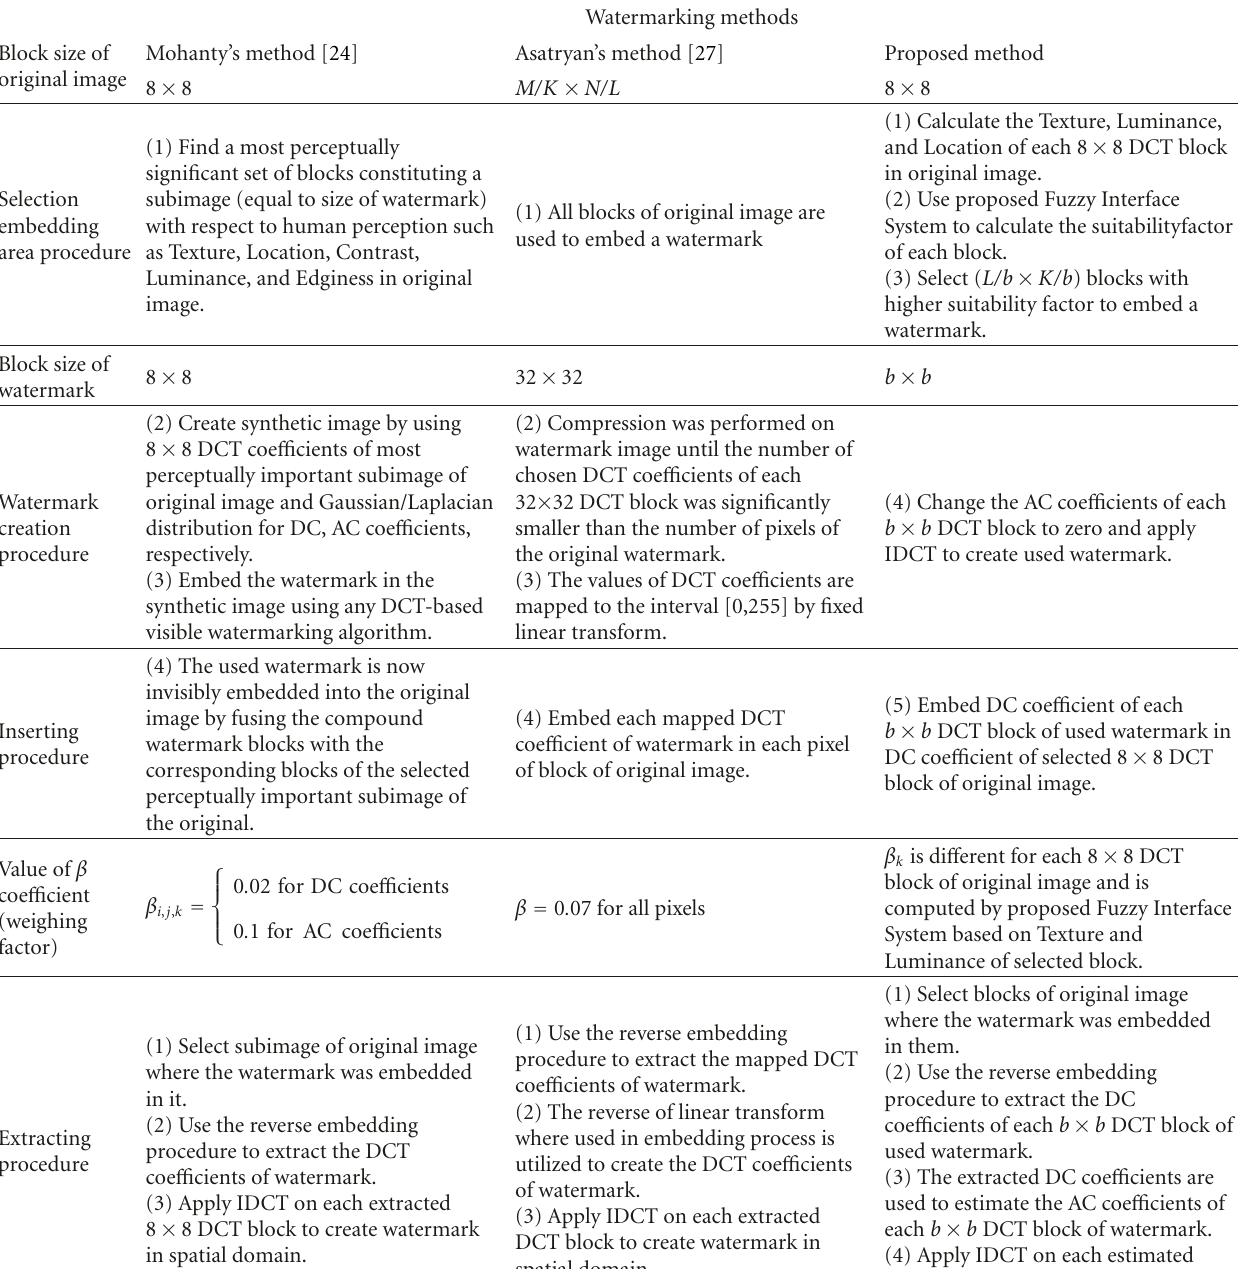
Table 3: Comparing the structures of D. Asatryan and N. Asatryan [27], Mahanty and Bhargava [24], and proposed watermarking methods. Watermarking